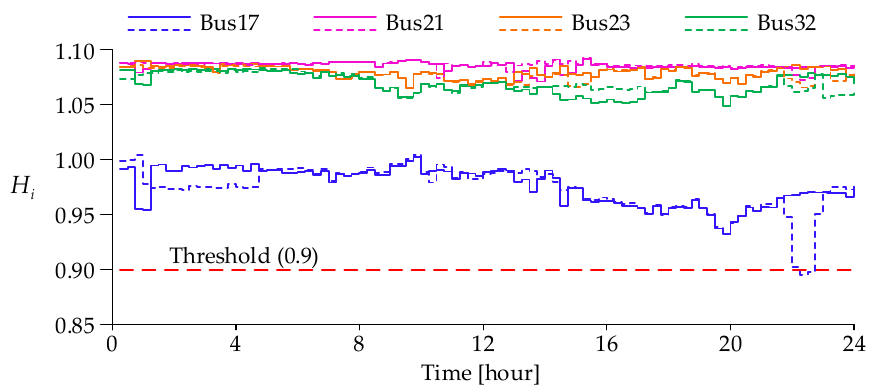
Figure 8. The values of voltage stability index